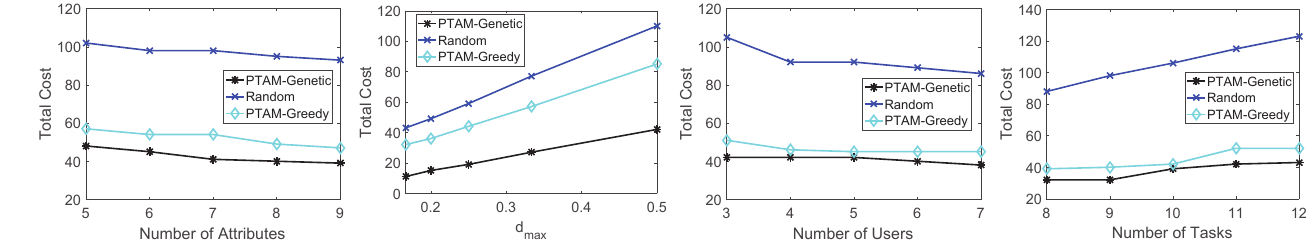
Figure 10. Performance comparisons on the epfl trace set.